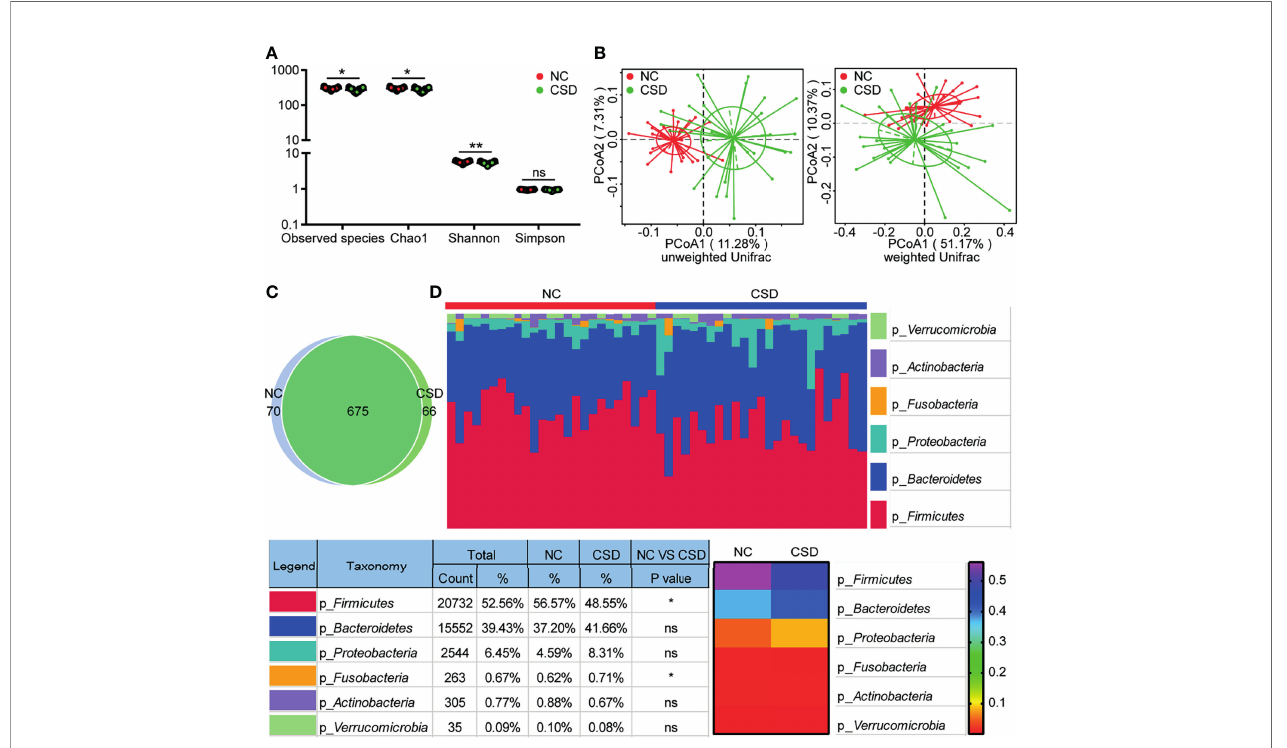
FIGURE 1 | Comparison of alpha diversity, beta diversity, OTU and phylum levels between the CSD group and NC group. (A) Three alpha diversity indices (Observed species, Chao1 and Shannon) were lower in the CSD group than in the NC group. (B) Based on unweighted unifrac distance and weighted unifrac distance, the CSD group and NC group clustered signi fi cantly. (C) Common OTUs and unique OTUs in the CSD group and NC group respectively. (D) The difference between the CSD group and NC group at the phylum level. NC, normal control; CSD, chronic spontaneous urticaria and symptomatic dermographism. Each point refers to one sample. The sample size of the NC group and CSD group was both 25. The numbers in the bar on the right of the heat map represent the relative abundance of phylum. *p < 0.05, **p <